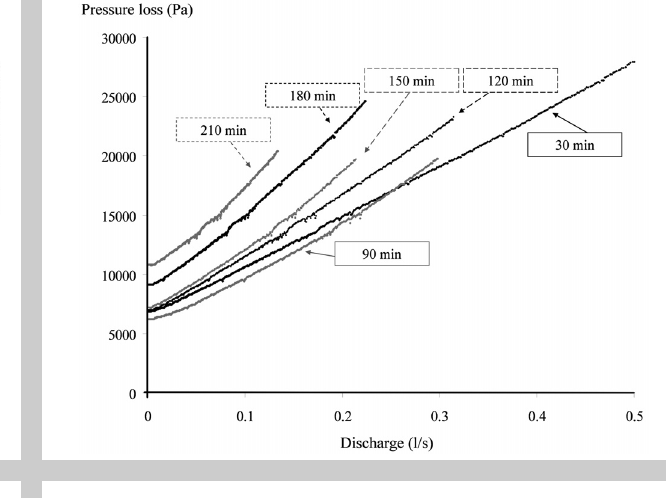
Figure 7 (left above): Rheometer results for SCC 2- 6. Both yield stress and vis- cosity increase with time. Remark that the 60 minute test has not been per- formed. Figure 8 (right above): Flow-test result for SCC 2-6. The results agree well with the rheometer results from Figure 7. Figure 9 (below): A large loss of workability leads to a large increase in yield stress and viscosity. As a result, large increases in pressure losses are also